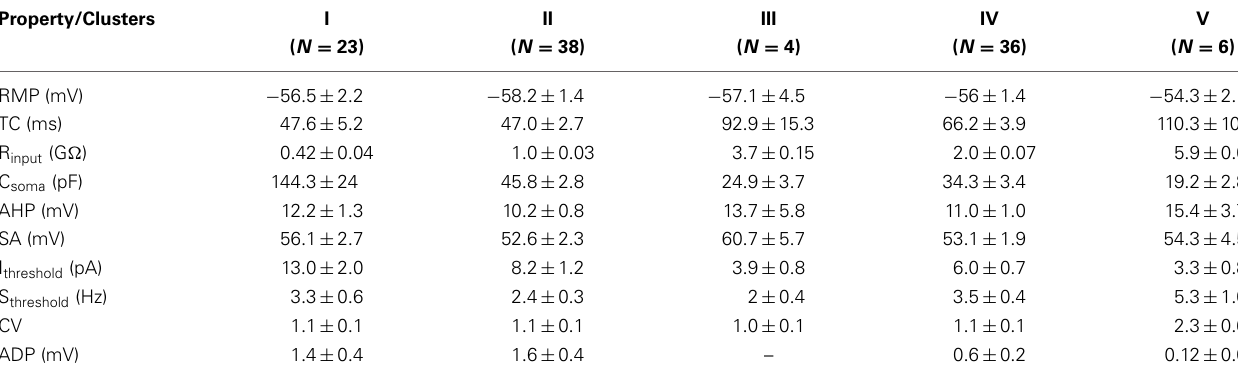
Table 2 | Intrinsic membrane properties of POA neurons measured in ACSF.